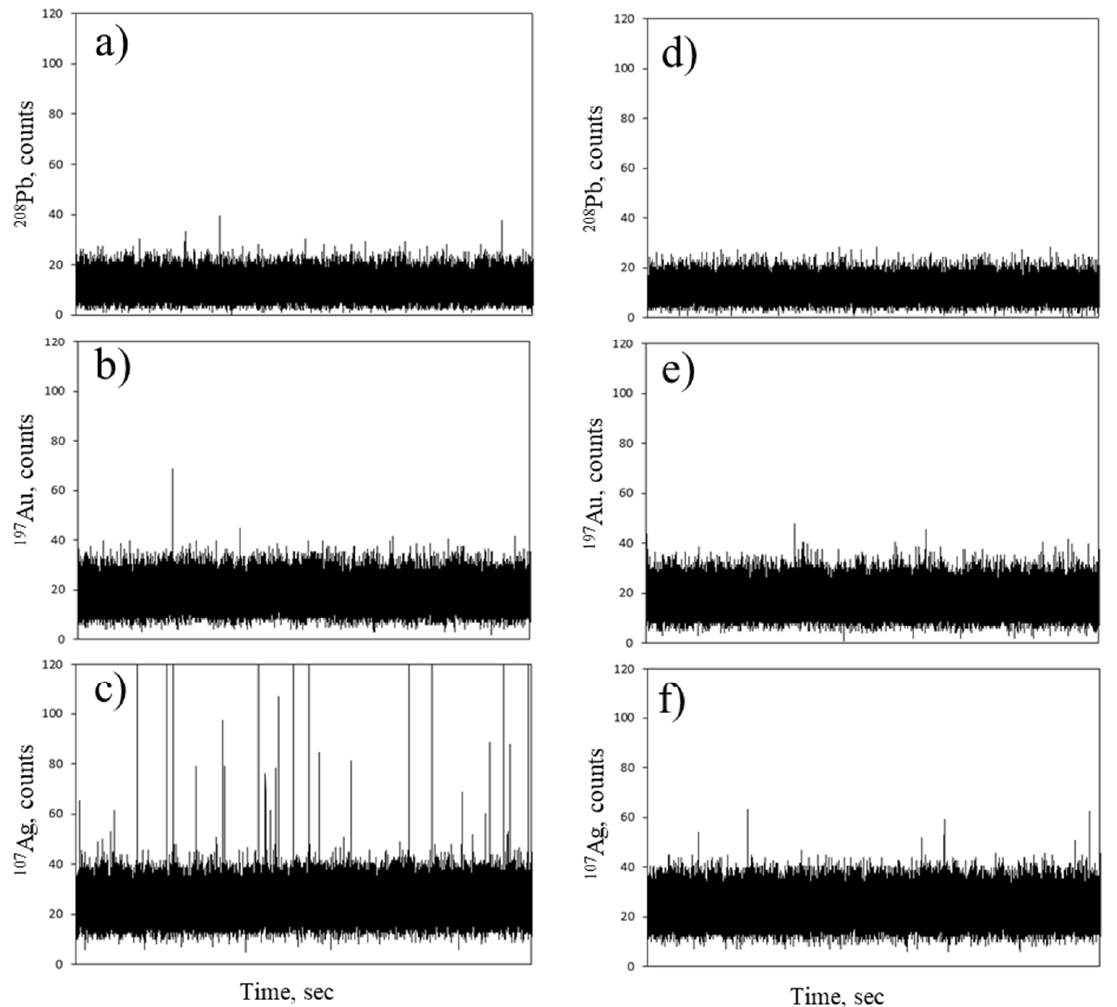
Figure 1. Time scans obtained by SP-ICP-MS for a water dispersed PSAA13 nanoplastic model material mixed with ( a ) ionic Pb; ( b ) ionic Au; ( c ) ionic Ag and for ionic solutions of ( d ) Pb, ( e ) Au, ( f ) Ag at the same concentration without nanoplastics. Table 1. Samples of labelled PSAA22, silver concentration and PSAA22:Ag